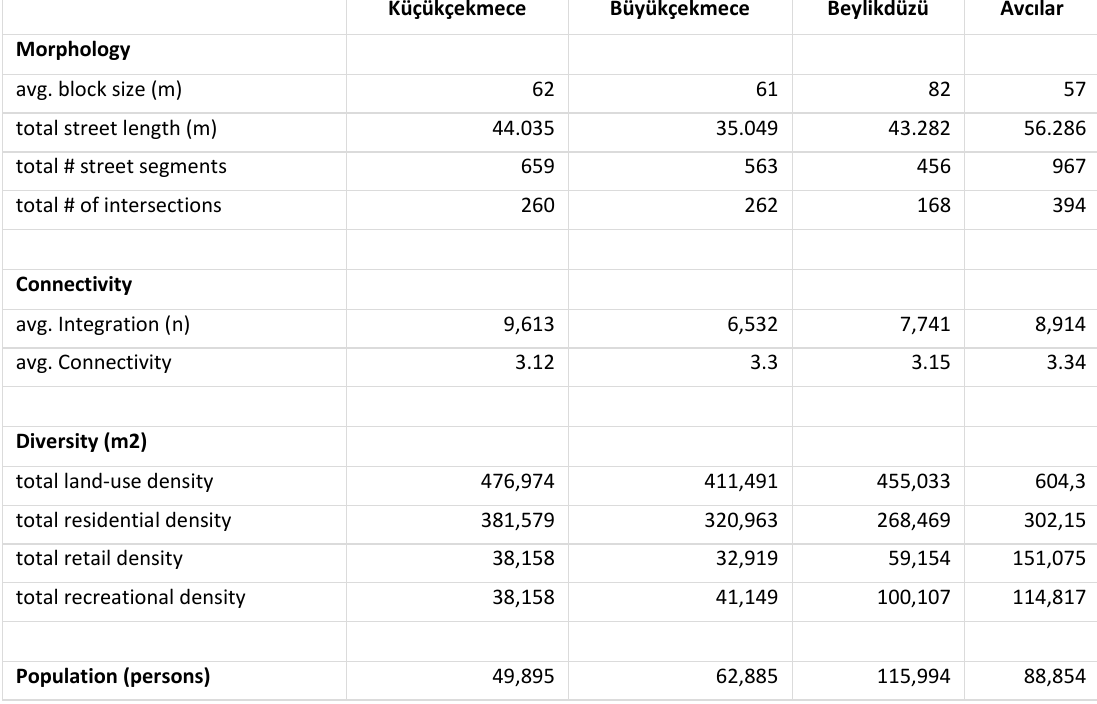
Table 2 Descriptive statistics summarizing urban form within study